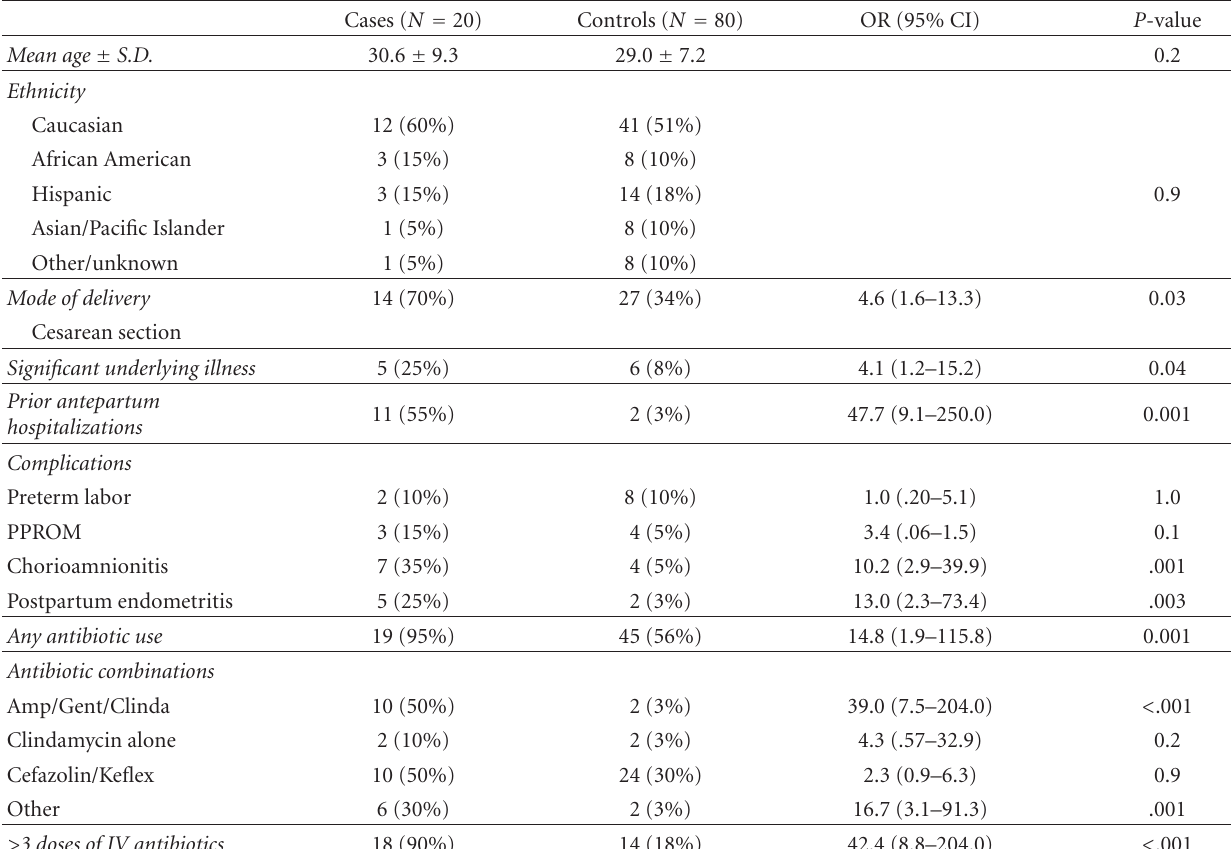
Table 2: Selected characteristics of CDI cases and of randomly selected